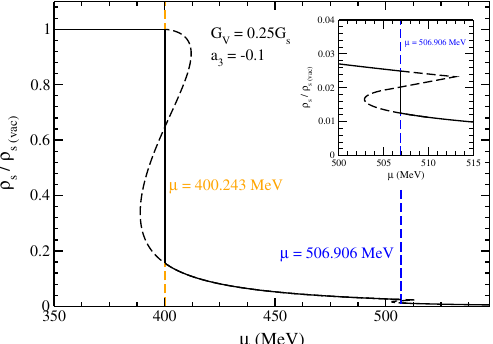
Fig. 8 Φ × μ for the PNJL0 model with G V = 0 . 25 G s and different a 3 values